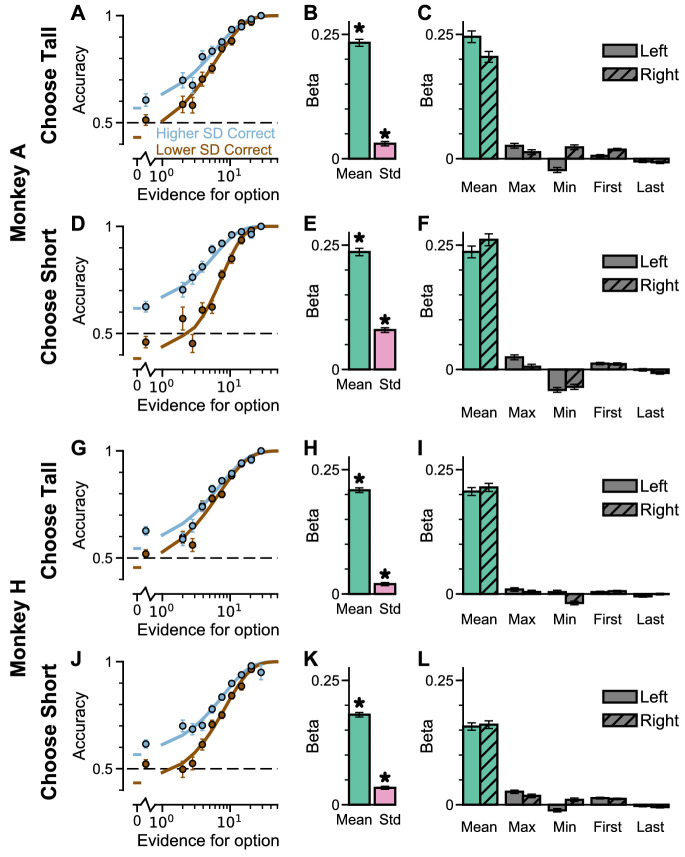
Extra information on Regular Trials, separated by ‘ChooseTall’ and ‘ChooseShort’ trials.The findings are very similar on both trial types. (A) The psychometric function of Monkey A when either the ‘Lower SD’ (brown) or ‘Higher SD’ (blue) stream is correct, on ‘ChooseTall’ trials. (B) A regression model using evidence mean and variability to predict Monkey A’s choices on ‘ChooseTall’ trials. Each regressor is the left-right difference of the mean and standard deviation of the evidence streams. This shows that both statistics are utilised by Monkey A to solve the task (mean evidence: t(ChooseTall) = 32.78, p(ChooseTall)<10−10; evidence standard deviation: t(ChooseTall) = 6.81, p(ChooseTall)<10−10). (C) A regression model including the mean, maximum, minimum, first, and last evidence values of both the left and right streams as regressors, in order to evaluate the contribution of each quantity on choices on ‘ChooseTall’ trials and the possibility that Monkey A is utilising strategies alternative to evidence integration and pro-variance bias. Evidently, Monkey A mainly relies on temporal integration to solve the task, as indicated by a strong mean evidence coefficient in both regression models. (D) The psychometric function of Monkey A when either the ‘Lower SD’ (brown) or ‘Higher SD’ (blue) stream is correct, on ‘ChooseShort’ trials. (E) The same regression model as (B) applied to Monkey A’s choices on ‘ChooseShort’ trials (mean evidence: t(ChooseShort) = 32.09, p(ChooseShort)<10−10; evidence standard deviation: t(ChooseShort) = 16.47, p(ChooseShort)<10−10). (F) The same regression model as (C) applied to Monkey A’s choices on ‘ChooseShort’ trials. (G–L) Same as (A–F) but for Monkey H. The statistics of the regression model in (H) are (mean evidence: t(ChooseTall) = 42.76, p(ChooseTall)<10−10; evidence standard deviation: t(ChooseTall) = 6.19, p(ChooseTall)=5.92−10), and (K) are (mean evidence: t(ChooseShort) = 40.43, p(ChooseShort)<10−10; evidence standard deviation: t(ChooseShort) = 10.97, p(ChooseShort)<10−10). All errorbars indicate the standard error.